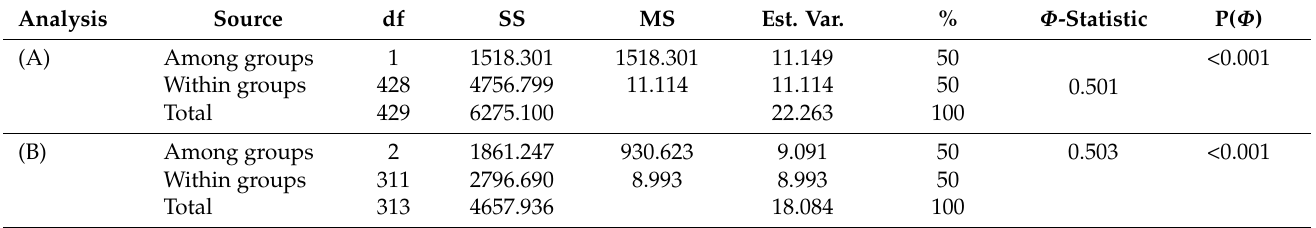
Table 2. Analysis of molecular variance for the partitioning of SSR markers diversity of landraces classified into two (A) as well as three groups (B) according to model-based cluster analysis and PHAS type. P( Φ )– Φ -statistical probability level after 999